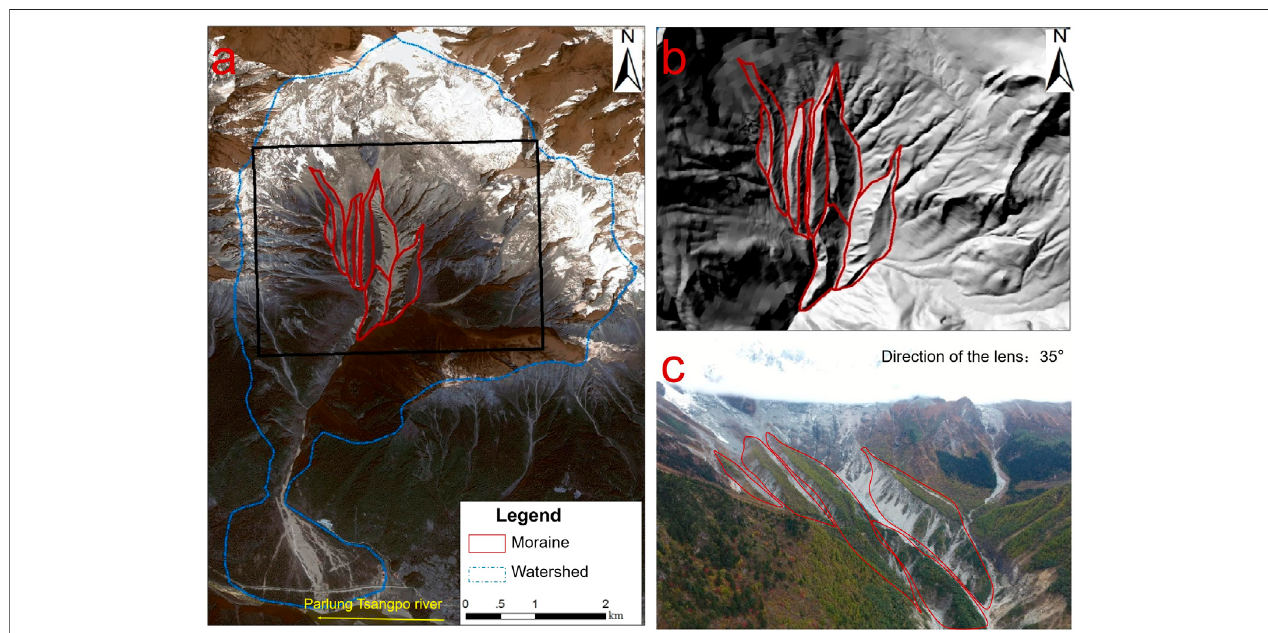
FIGURE 3 | (A) Sedimentary feature of moraine in remote-sensing image; (B) Topography features of moraine deposit; (C) Accumulation characteristics taken by UAV unmanned aerial vehicle (2016.09.14).